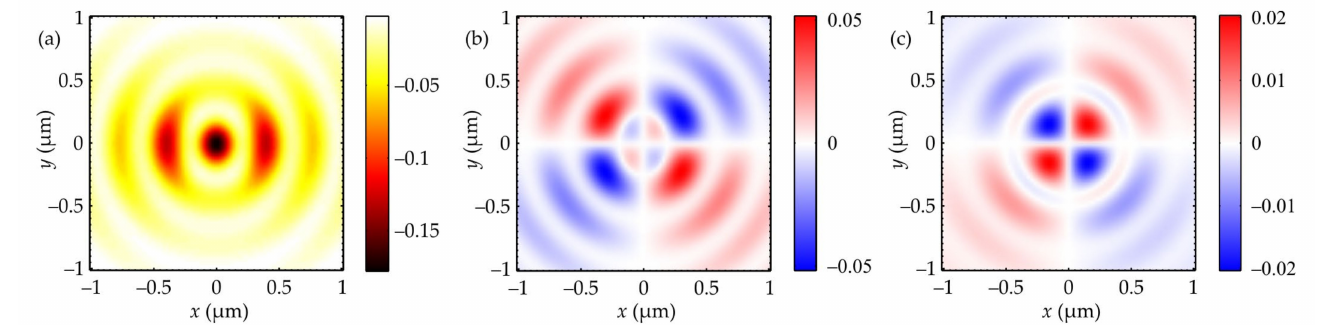
Figure 3. Distribution of the Stokes vector components s 1 ( a ), s 2 ( b ) and s 3 ( c ) at a distance λ after the